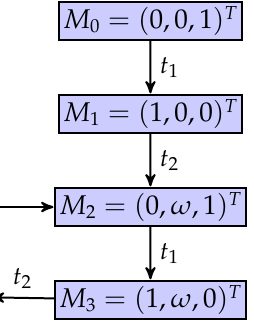
Figure 2. The coverability